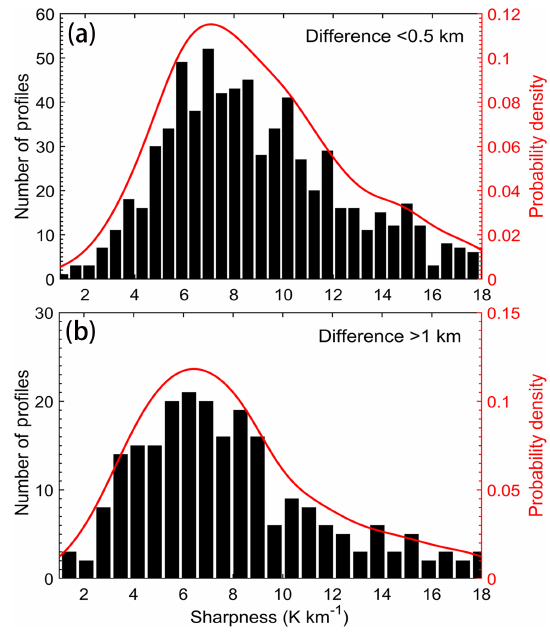
Figure 5. Histogram distribution of the tropopause sharpness for (a) difference of < 0 . 5km and (b) difference of > 1km, respec- tively, between the LRT and the RT.